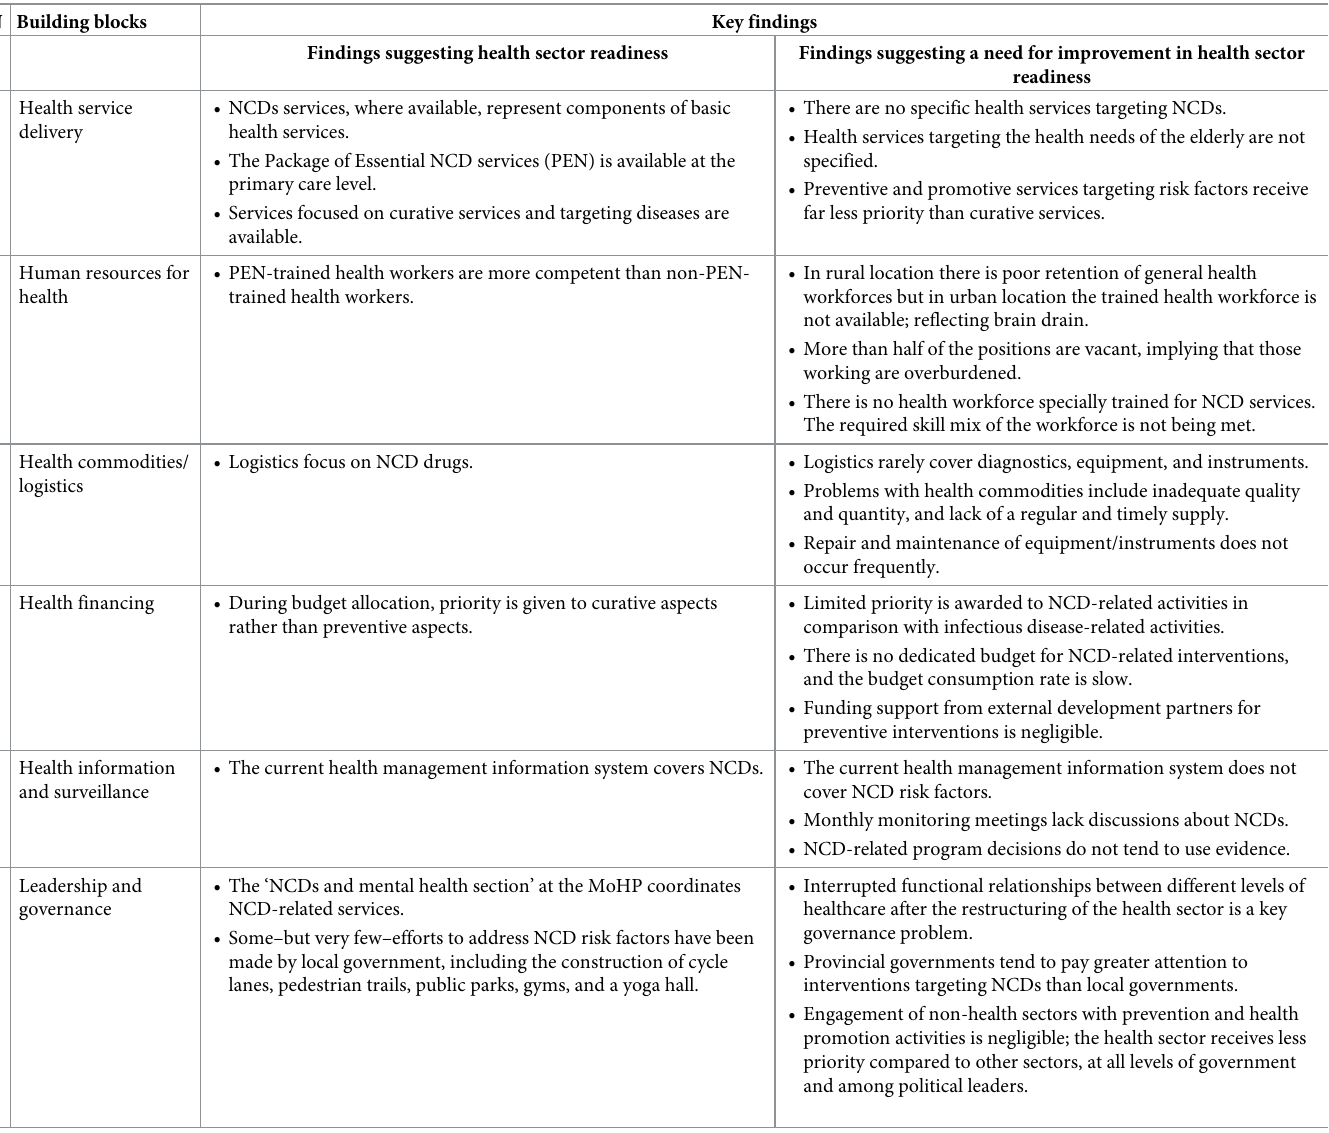
Table 4. Summary findings regarding perspectives on health sector readiness for NCD prevention and